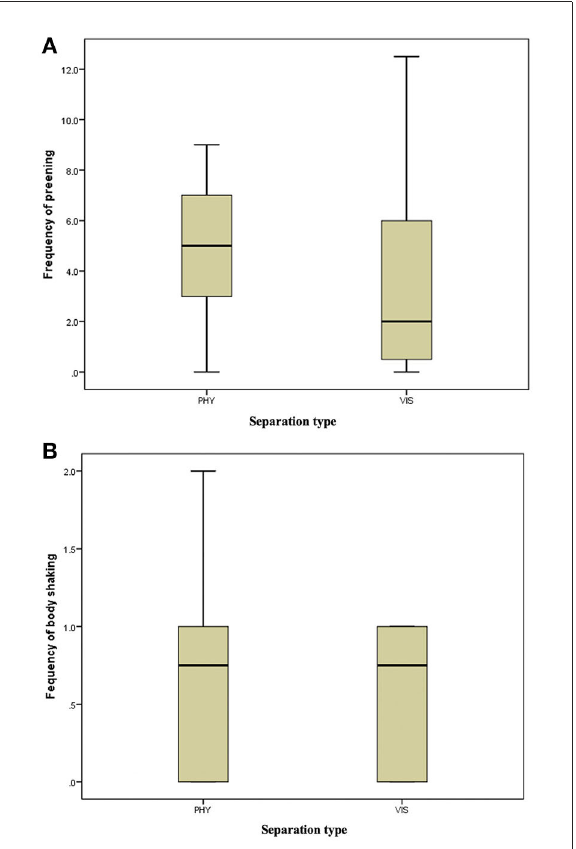
FIGURE4 (A) Frequency of preening of the mother hens when subjected to 10-min physical (PHY) or visual (VIS) separation from their chicks. (B) Frequency of body shaking of the mother hens when subjected to 10-min physical (PHY) or visual (VIS) separation from their